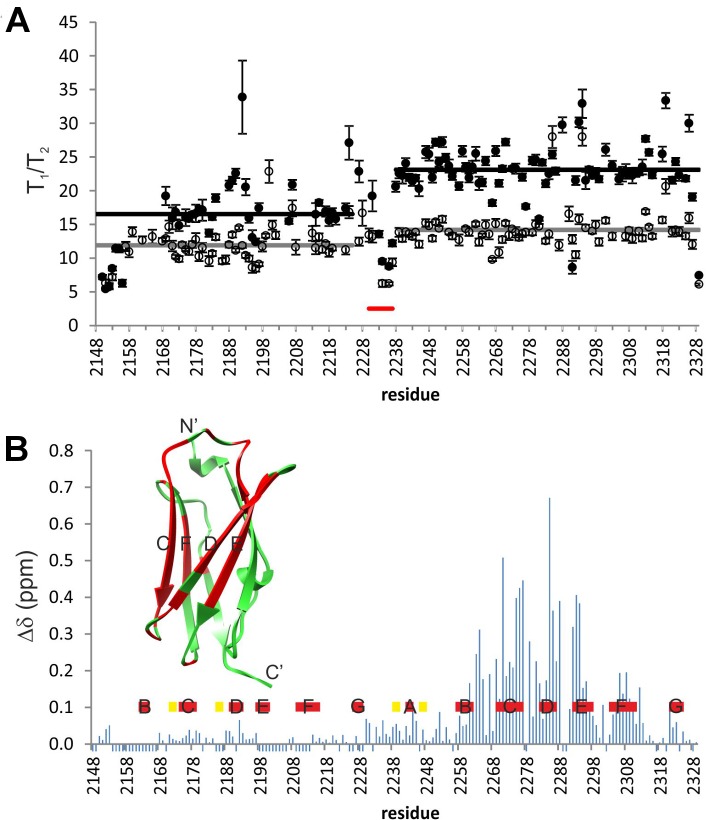
NMR spectroscopy of 15N-IgFLNa∆A20–21.
A T1/T2 for free (open circles) and migfilin-bound (closed circles) 15N-IgFLNa∆A20–21. For each domain the average value is shown with a horizontal line. Domain linker region is indicated with a red bar. B Chemical shift perturbations in 15N-IgFLNa∆A20–21 upon titration with migfilin peptide. Residues corresponding to the β strands are shown with the red bars. Shift changes of ∆δ > 0.1 ppm are shown in the structure of IgFLNa21 in red. Residues with no data are assigned an arbitrary value -0.02 ppm.